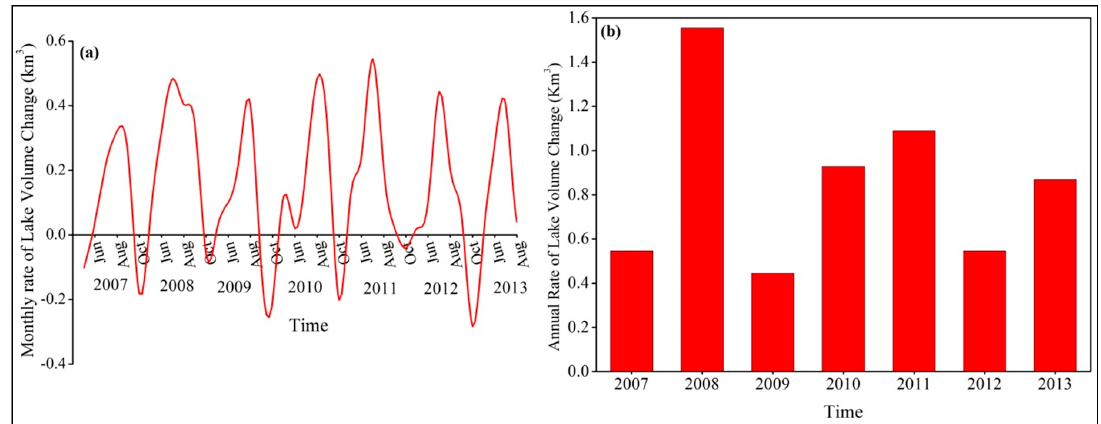
Figure 5. ( a ) Monthly and ( b ) annual rate of change of the Nam Co Lake volume from 2007 – 2013.